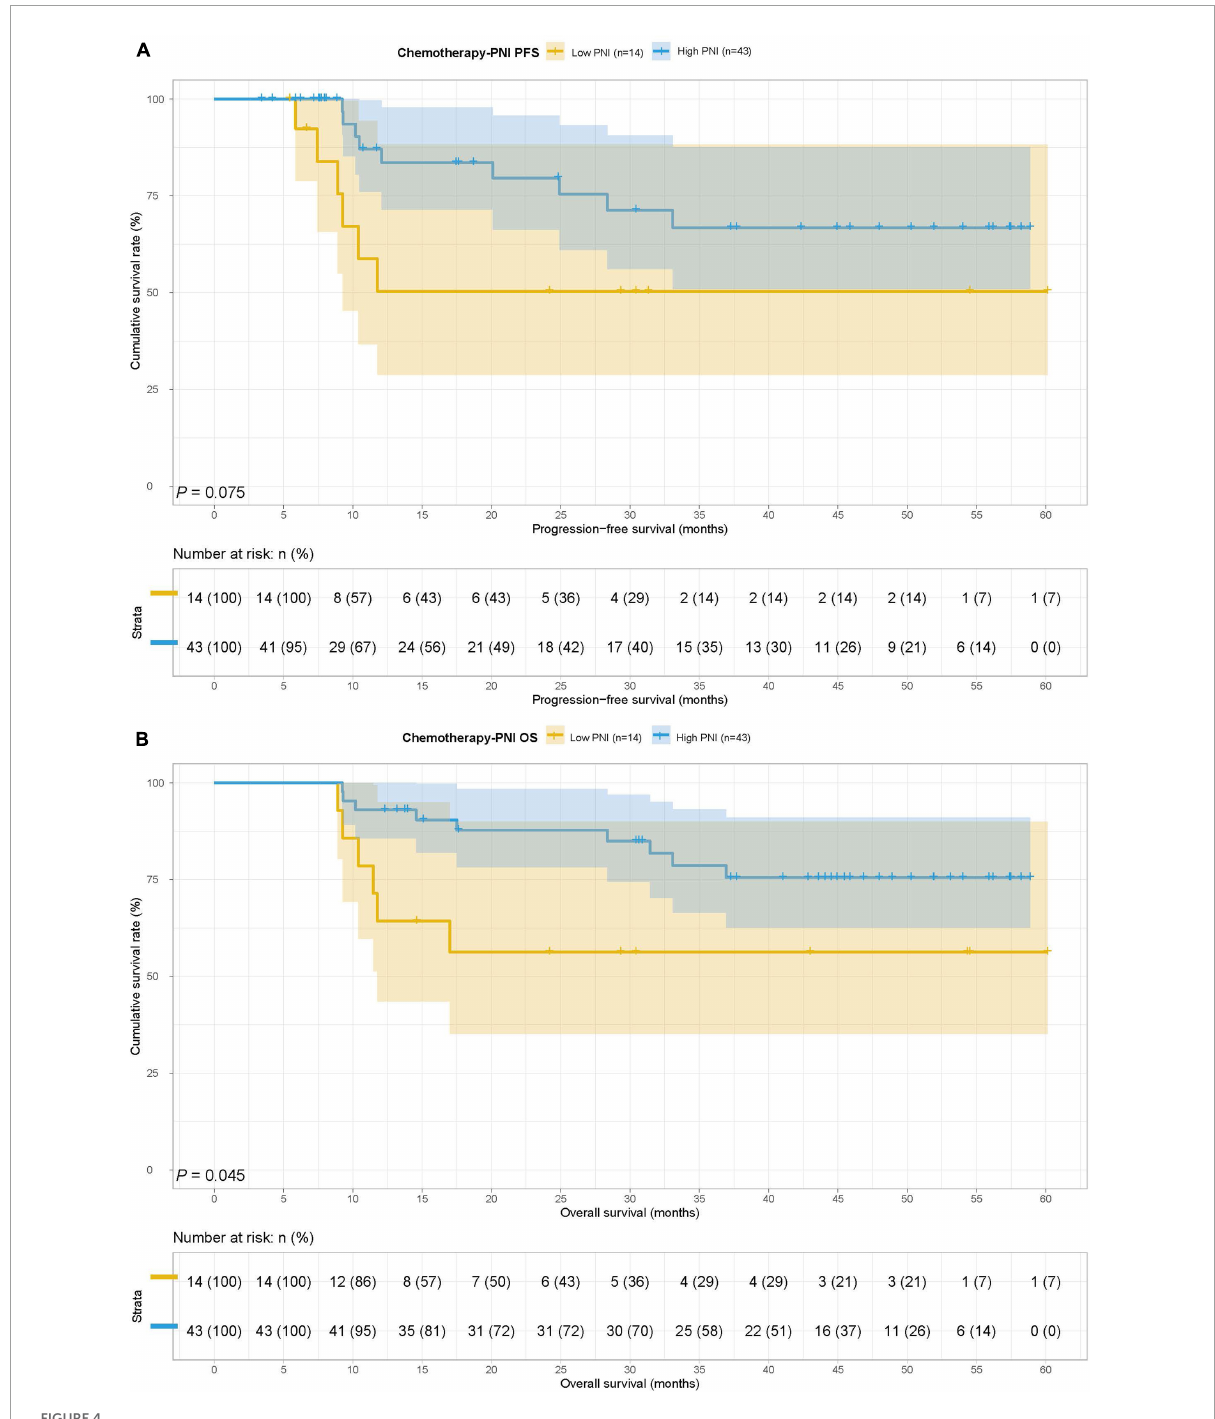
FIGURE4 Prognostic nutrition index related survival curve of (A) PFS and (B) OS in the chemotherapy group.